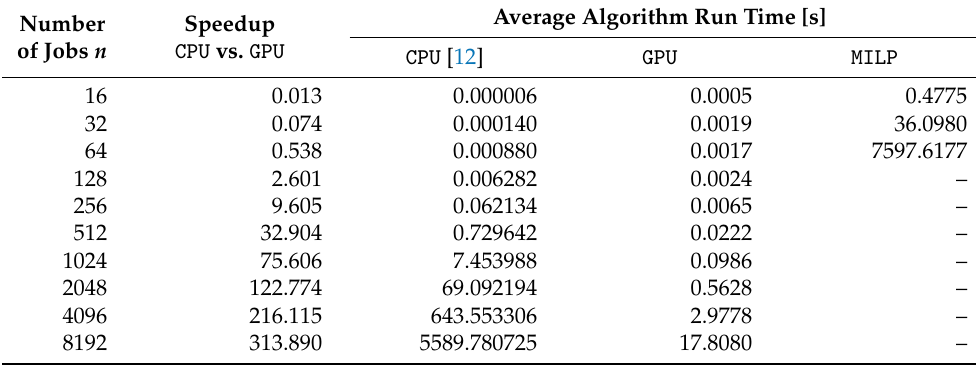
Table 1. Results of the experiments; for MILP and n > 64 no optimal solutions were found in 8 h of computations per